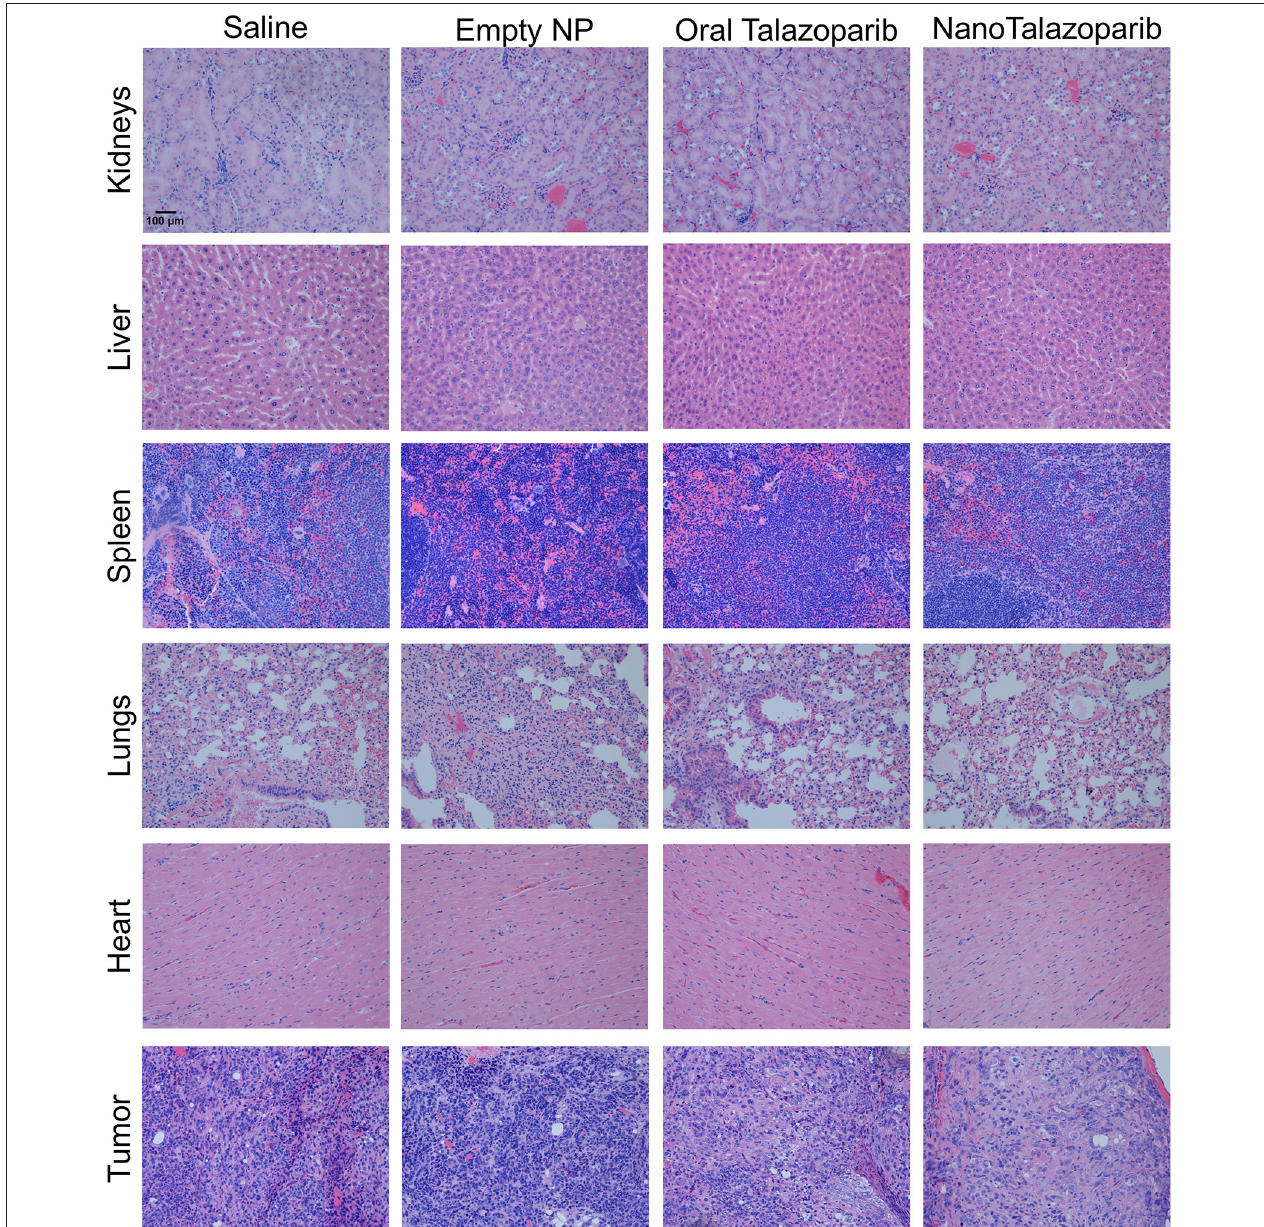
FIGURE 7 | Representative slices of organs and tumors stained with hematoxylin and & eosin demonstrate no treatment associated toxicities in any groups after 8 weeks of continuous treatment. 20 × magnification.